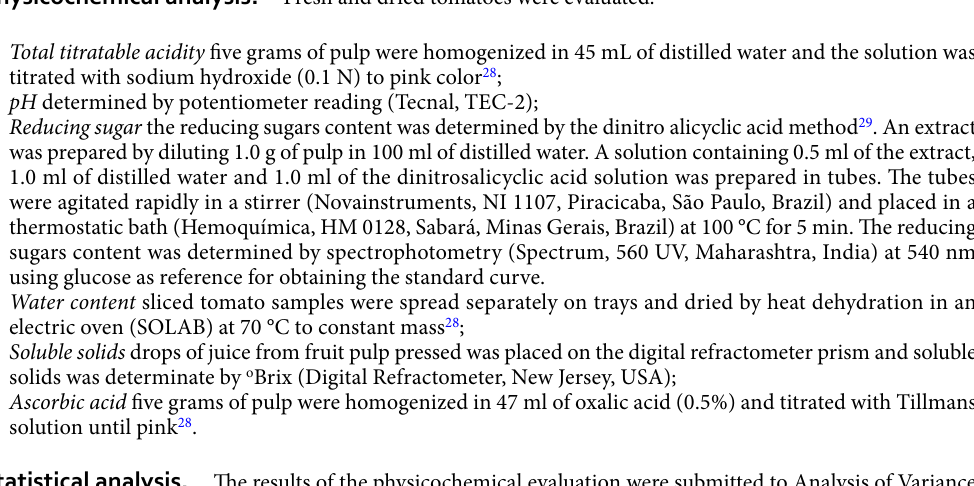
model evaluation 27 . Equation (2):